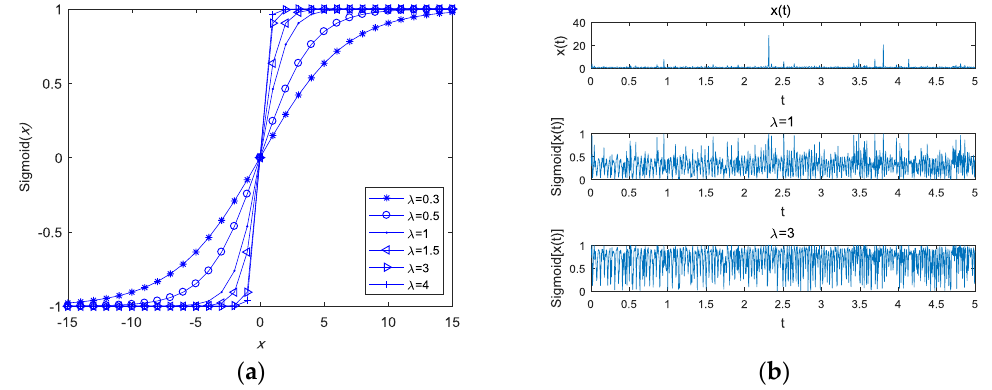
Figure 2. The tuneable Sigmoid function curves of the real signal with respect to λ . ( a ) x ( t ) is the real signal; ( b ) x ( t ) is the real signal with impulsive